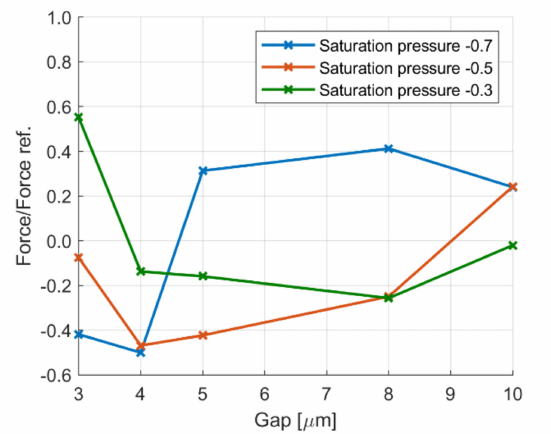
Figure 25. Bearing capacity is generated by a partial texturing configuration. Influence of the gap for di ff erent values of saturation pressure. Set B cavitation coe ffi cients. Square dimple with side 50 µ m and depth 10 µ m, sliding velocity 10 m / s.